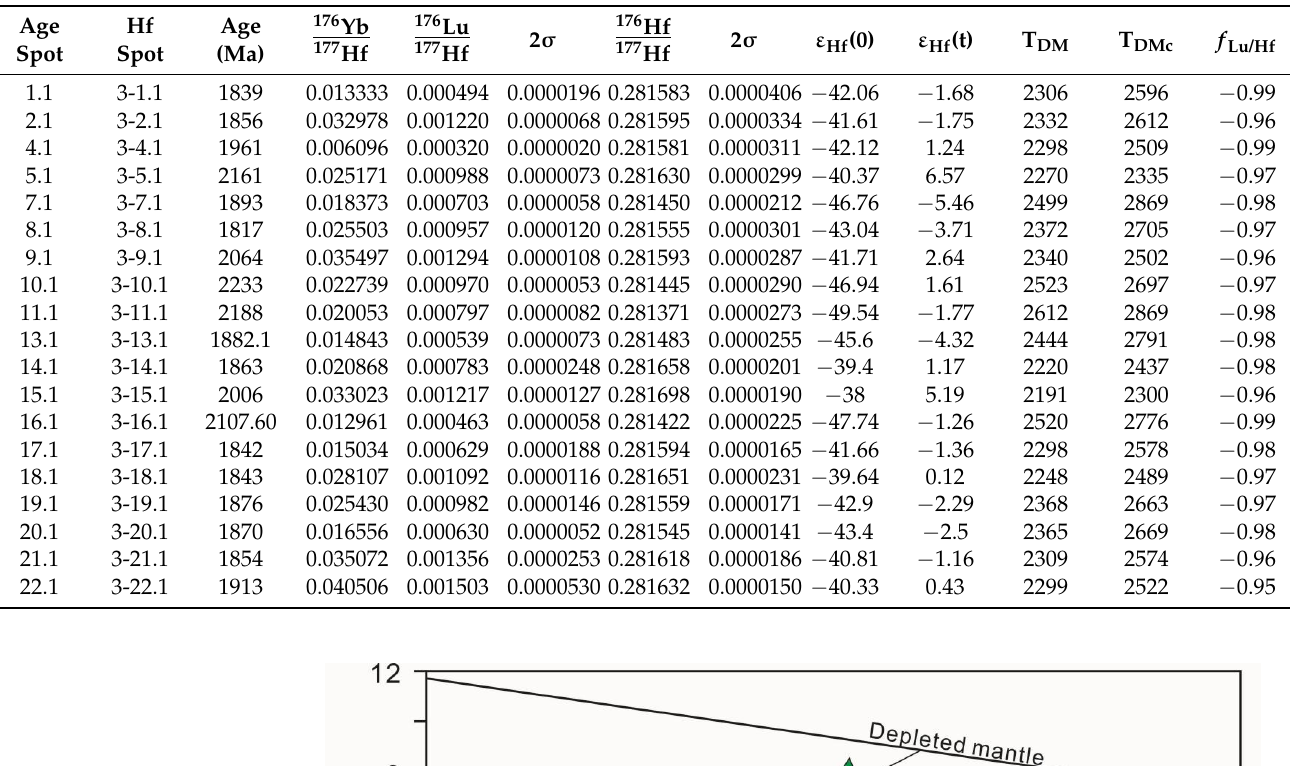
Table 2. Zircon Lu-Hf isotopic data of zircons for granitic gneiss sample ZJ1-3 from drill cores ZJ-1 at northeastern Ordos Basin.